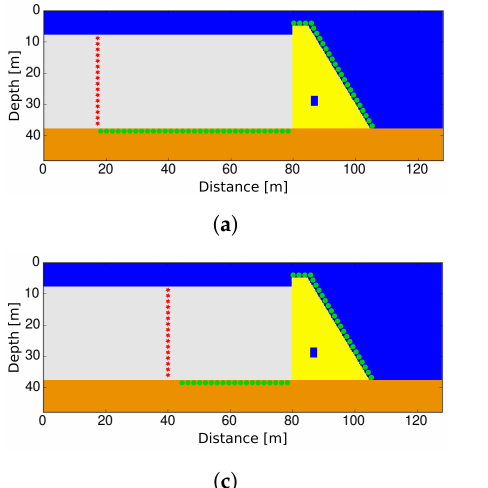
Figure 4. Acquisition setup showing distribution of sources ( (cid:70) ) and sensors/receivers ( • ) in the domain. Sensors are placed at the bottom of the reservoir to pick up reflections resulting from anomalies in the foundation. ( a ) Setup 1 ( b ) Setup 2 ( c ) Setup